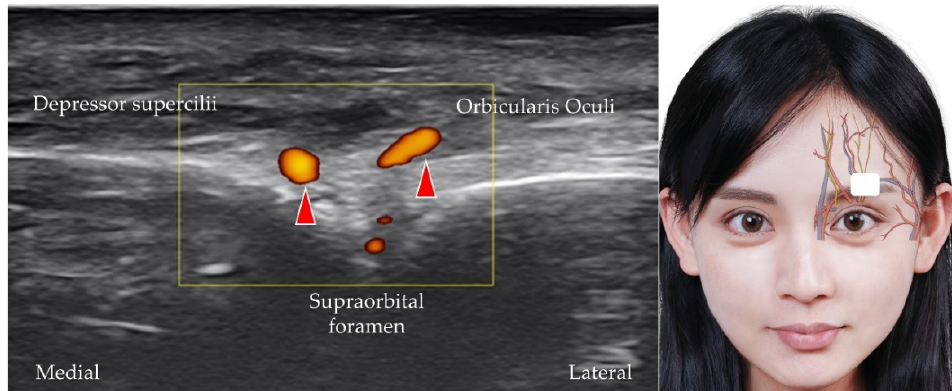
Figure 6. Power Doppler ultrasound imaging of the supraorbital artery (red arrowheads) and its branches. White square , footprint of the ultrasound transducer.